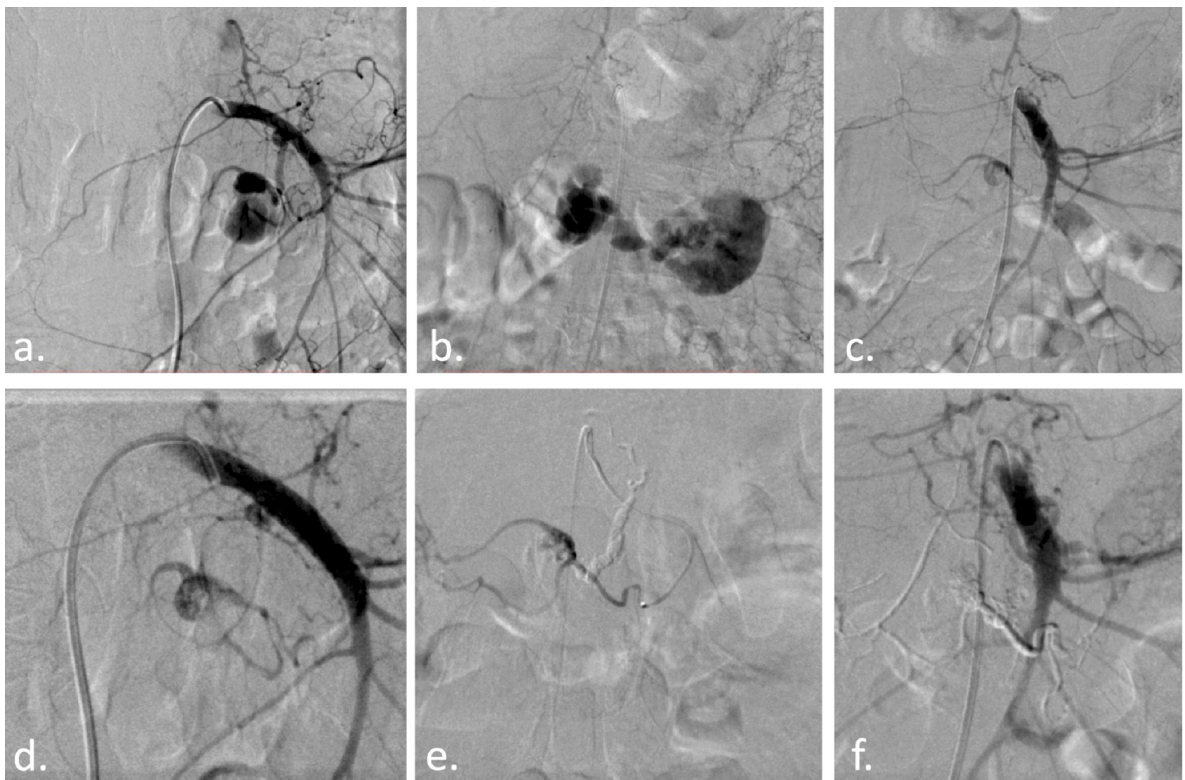
Figure 2. With the patient under conscious sedation, via a right common femoral artery approach, the superior mesenteric artery was catheterized with a 5F Cobra catheter and a Terumo 35 guidewire (Figure 2a). While injecting the contrast agent to obtain a better working projection, the pseudoan- eurysm ruptured, and acute extravasation of the contrast agent was noted (Figure 2b). A Direxion microcatheter (Boston Scientific, Marlborough, MA, USA) with a 14 guidewire was selectively ad- vanced in the inferior pancreaticoduodenal artery and another small pancreatic branch (Figure 2c– e), followed by injection of a mixture of 1 mL Glubran 2 (GEM, Viareggio, Italy) with 2 mL Lipiodol (Guerbet, Villepinte, France) until complete obliteration of the pseudoaneurysm was obtained (Fig- ure 2f). The patient was hemodynamically stable at the end of the procedure and was discharged 6 days later in a good condition without any active bleeding signs. ( a ) Superior mesenteric artery contrast injection reveals an oval-shaped pseudoaneurysm; ( b ) Acute contrast extravasation during contrast injection; ( c ) Residual filling of the pseudoaneurysm through collaterals, despite IPD artery occlusion with glue; ( d ) Collateral branch responsible for residual filling; ( e ) Microcatheter in the inferior pancreaticoduodenal artery; ( f ) Complete obliteration of the pseudoaneurysm with the glue cast visible. Given the high morbidity and fatality rates associated with pancreaticoduodenal pseudoan- eurysm rupture [23], immediate treatment is vital. Several recent studies in the literature demonstrate promising outcomes for endovascular embolization. Suzuki et al. [24] showed a series of seven patients embolized using micro-coils, with a 100% success rate and no long-term (28 months average, range 5–65 months) recurrence of symptoms or bleeding. Waguri et al. [23] also reported effective embolization of an anterior inferior pancreaticoduodenal artery pseudoaneurysm that perforated in the portal system. Furthermore, Krishna et al. [20] described a 60-year-old female patient who presented with melena and hematemesis caused by a rupture of the lower pancreaticoduodenal artery pseudoaneurysm at the level of the intestinal wall. Ren et al. [21] reported on their endovascular treatment of 159 patients with visceral artery aneurysms and pseudoaneurysms, with 96.9% of patients successfully treated and a 1.9% mortal- ity rate at 30 days. Similar to our case, Mitrovic et al. [13–15] reported successful endovascular reso- lution of a posterior inferior pancreaticoduodenal artery pseudoaneurysm using the sandwich tech- nique, in which the pseudoaneurysm inflow and outflow were embolized with coils. Jang et al. [16], on the other hand, embolized the pseudoaneurysm with an N-Butyl-Cyanoacrylate-lipiodol com- position. Gurala et al. [17] also reported an effective embolization of a pseudoaneurysm from the gastro-duodenal artery, using coils. Inferior pancreaticoduodenal artery pseudoaneurysms may be diagnosed using ultrasound, CT, or visceral angiography with sensitivities of 50%, 67%, and 100%,